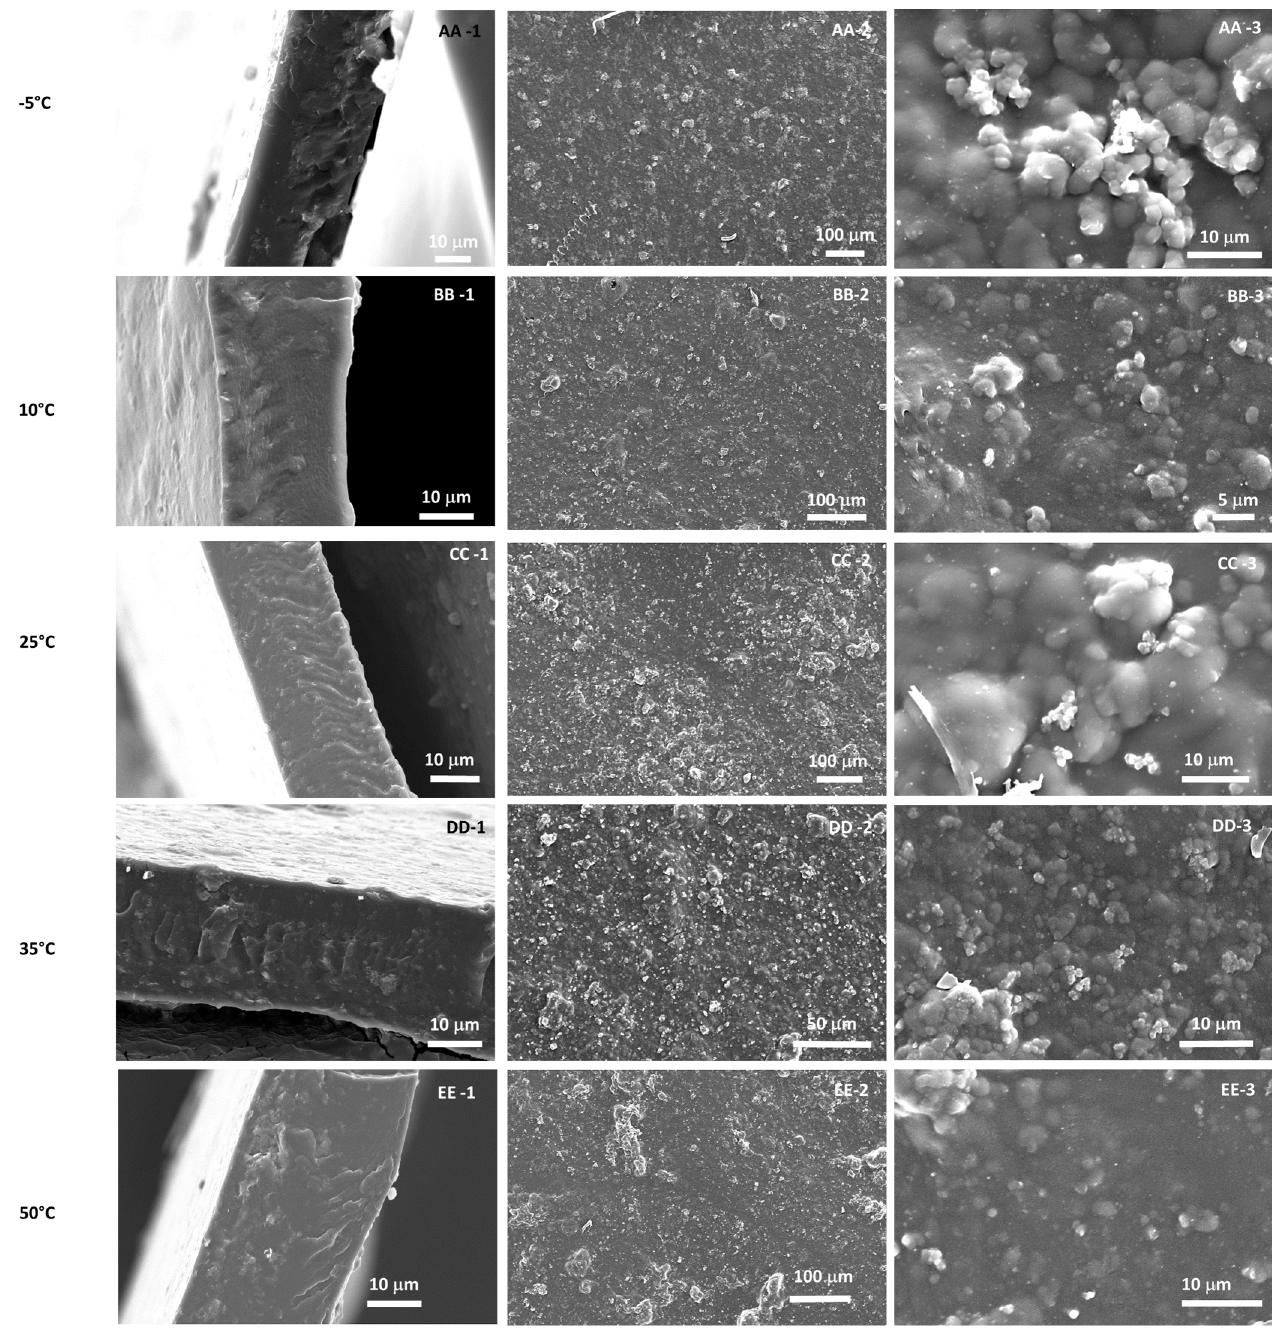
Figure 6. SEM cross sectional (-1) and surface (-2, -3) images from PEBAX-ZIF-8 cast at different temperatures (AA: − 5 °C, BB: 10 °C, CC: 25 °C, DD: 35 °C, EE: 50 °C).